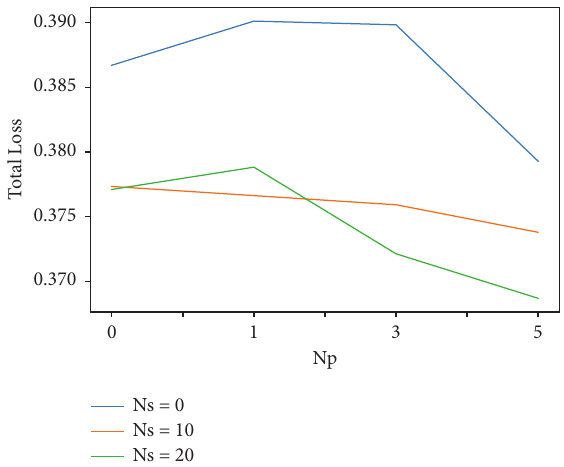
Figure 8: Total loss of all 3D-CNN models.